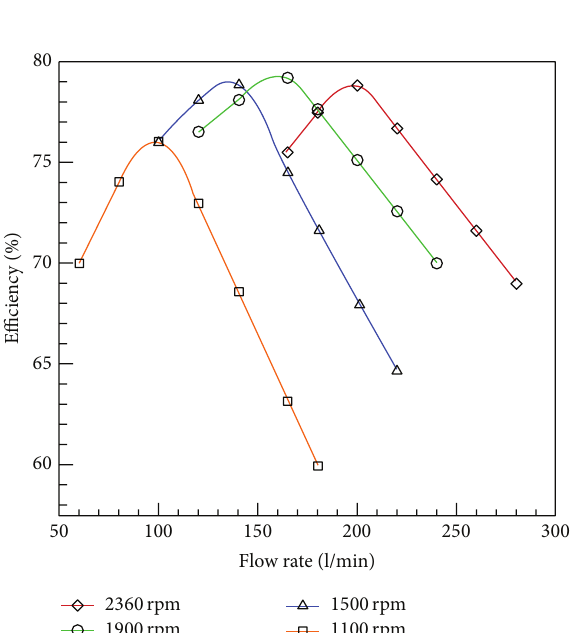
Figure 6: Ratio of efficiency versus coefficient of discharge.